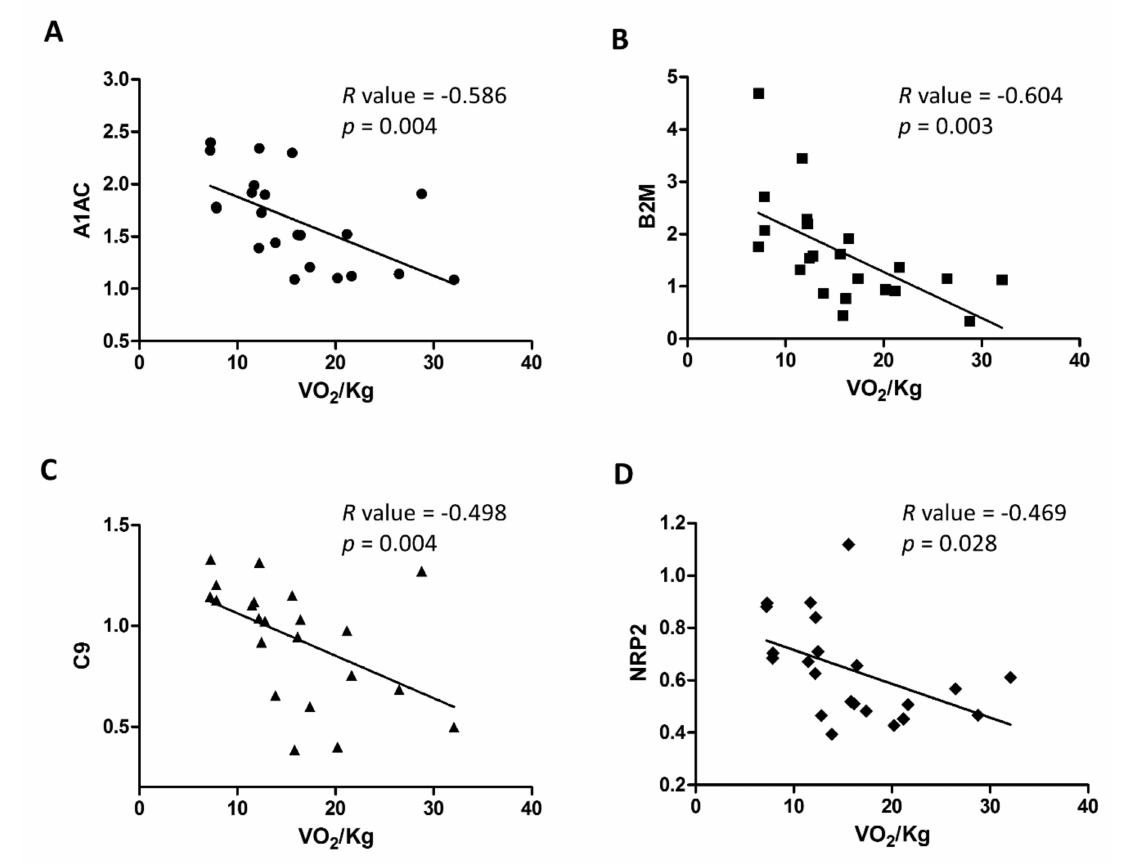
Figure 3. Correlation of selected features ( A – D ) with VO 2